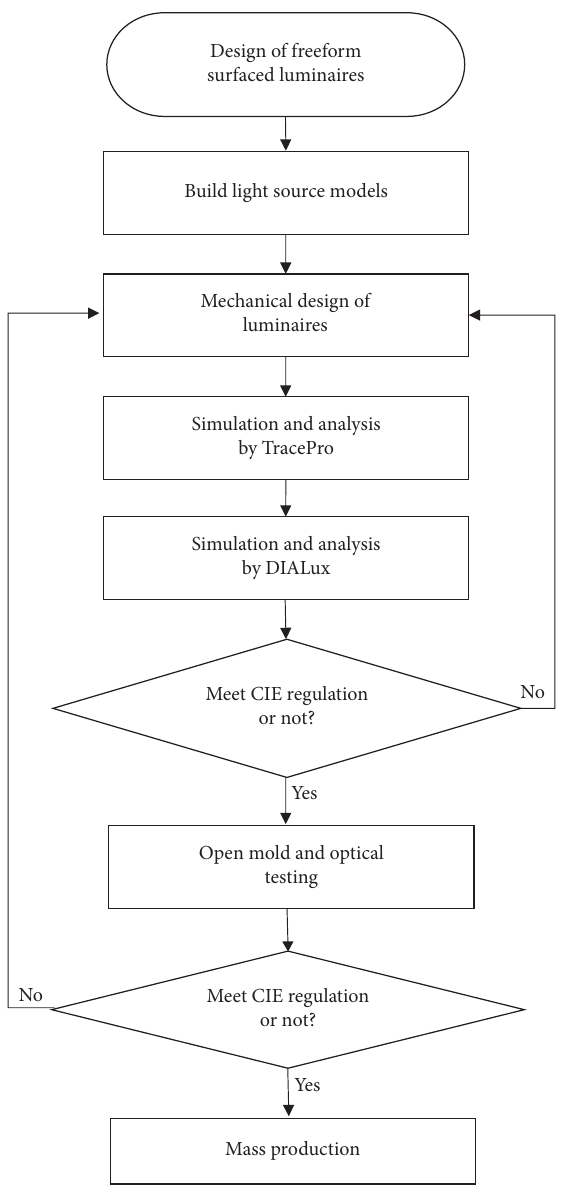
Figure 1: Flow chart for the design of a freeform-surface street light luminaire [6, 23].